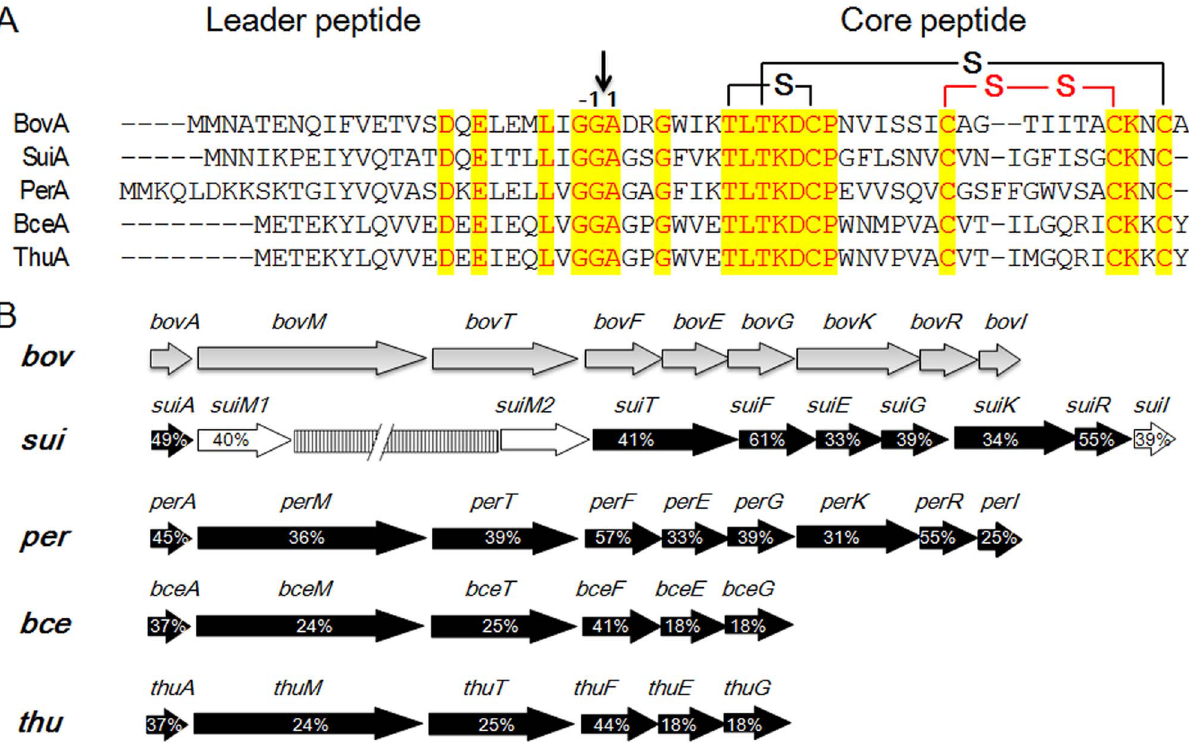
Figure 1. Revealing of bovicin HJ50-like lantibiotic gene clusters. (A) Sequence analysis of precursor peptides of BovA-like peptides including BovA, SuiA, PerA, BceA and ThuA. The residues in red of yellow background indicated identical amino acids in all aligned precursors. The thioether bridges (black) or disulfide bridge (red) illustrated the ring topology of bovicin HJ50. The vertical arrow indicated the processing site (between Gly-1 and Ala1) for BovT to release mature bovicin HJ50. (B) Bovicin HJ50-like lantibiotic gene clusters. Percentages in horizontal arrows represented the identities of the lantibiotic biosynthesis-related proteins with that of bov locus.